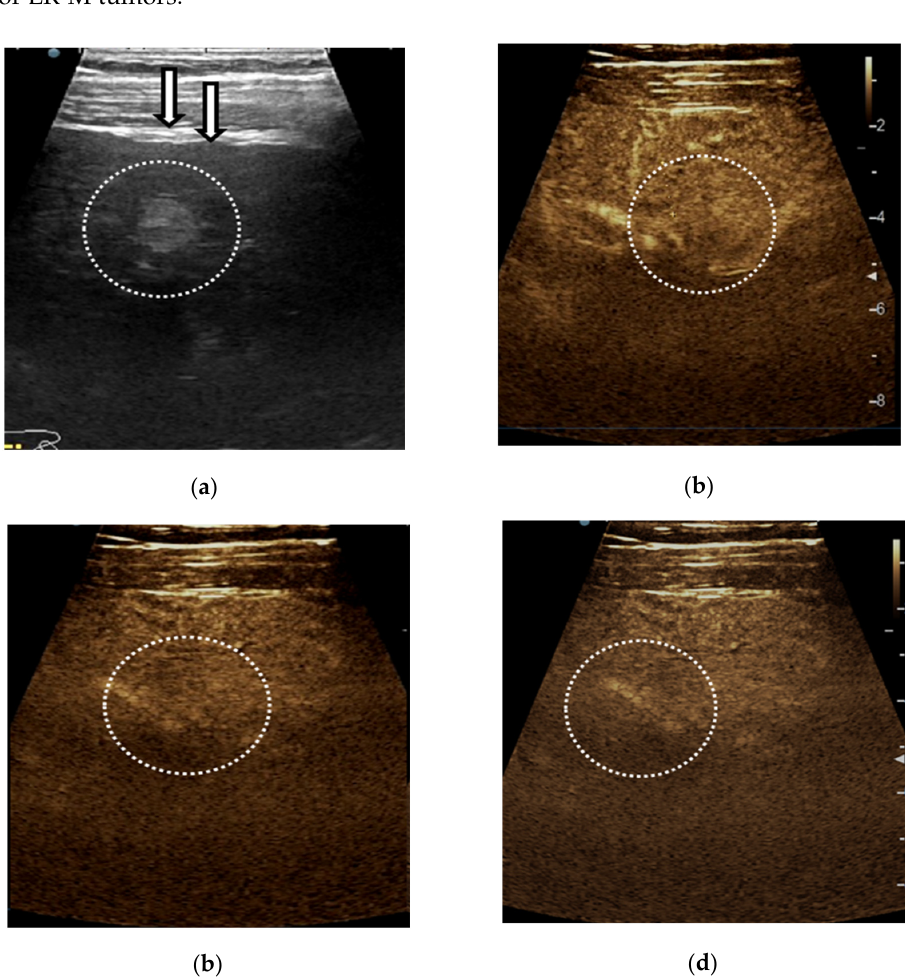
Figure 6. Example of LI-RADS-2 liver lesion. Regenerative nodule <10 mm depicted by linear probe exam in a patient with hepatitis C cirrhosis. The ultrasound exam shows a nodular liver surface and a subcapsular hyperechoic liver lesion ( a ). On contrast-enhanced ultrasound (CEUS) the nodule shows the isoenhancing aspect in the arterial ( b ), portal-venous ( c ) and late phase ( d ). 84 nodules (43.9%) were established as LR-5 and 81 of them (96.4%) were accurately diagnosed as HCC (Figure 7). The other 3 cases mistakenly graded were: one cholangio- carcinoma, one malignant transformed adenoma and one subcapsular hemangioma with